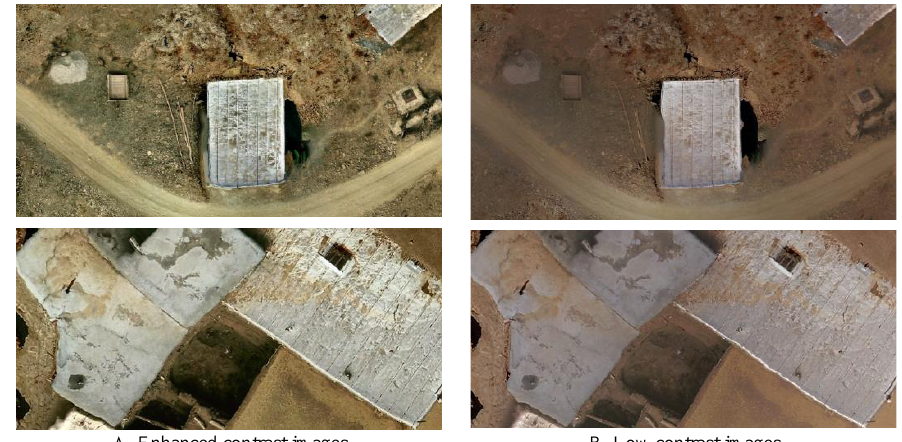
B. Low contrast images A. Enhanced contrast images